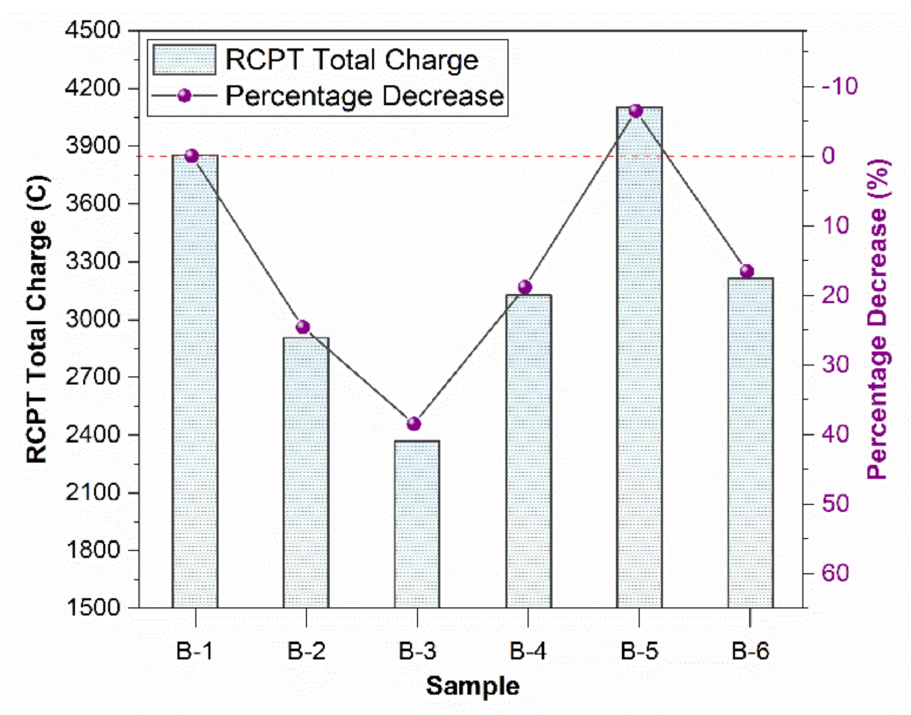
Figure 5. RCPT value of charge after freeze-thaw